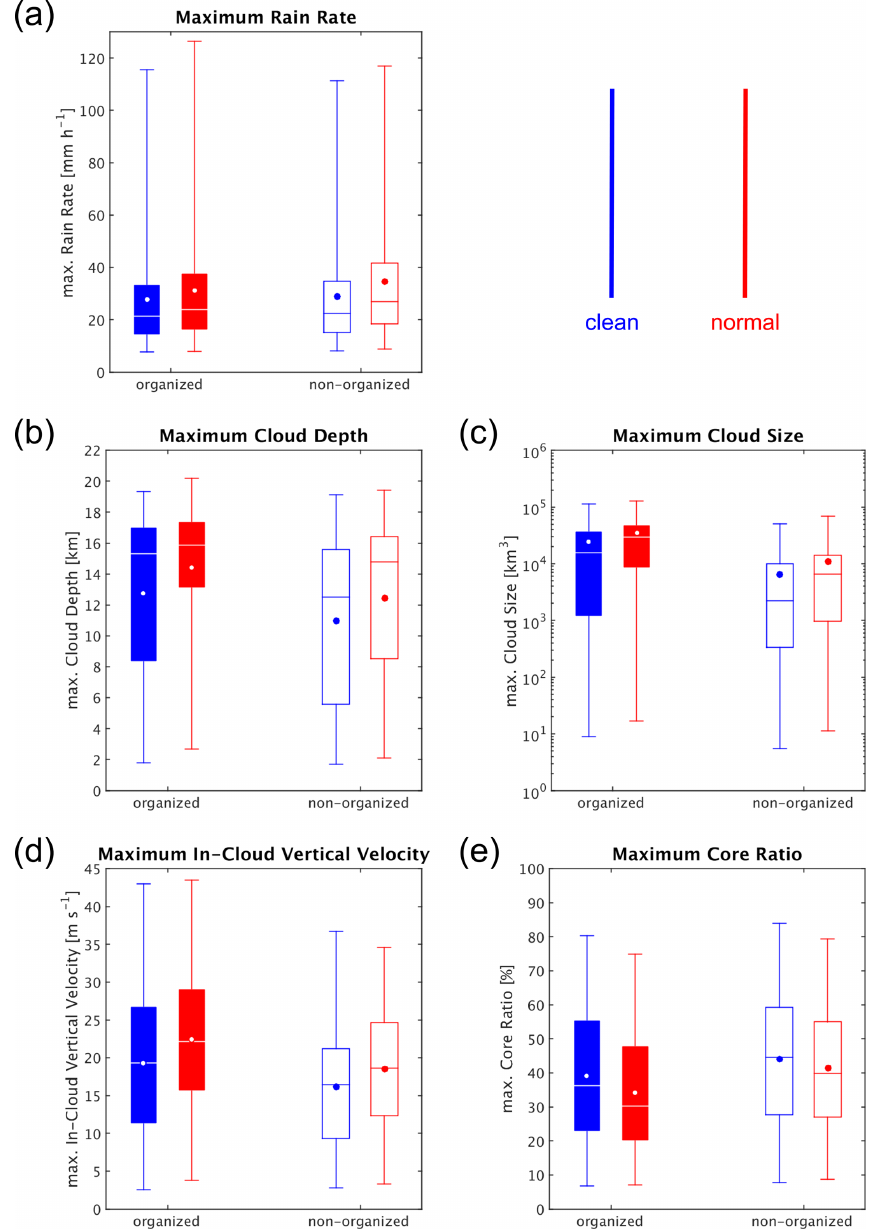
Figure 8. The box-and-whisker plots of the maximum (a) rain rate, (b) cloud depth, (c) cloud size, (d) in-cloud vertical velocity, and (e) core ratio during the lifetime of the diurnal precipitating systems. The core ratio is defined as the proportion of the clouds with a vertical velocity greater than 0.5ms − 1 , indicating the ratio of the updraft region. The blue and the red boxes represent the results of the clean and the normal scenarios, respectively. The filled boxes represent the organized regime, while the unfilled boxes represent the non-organized regime. The dots on the box-and-whisker plots are the mean